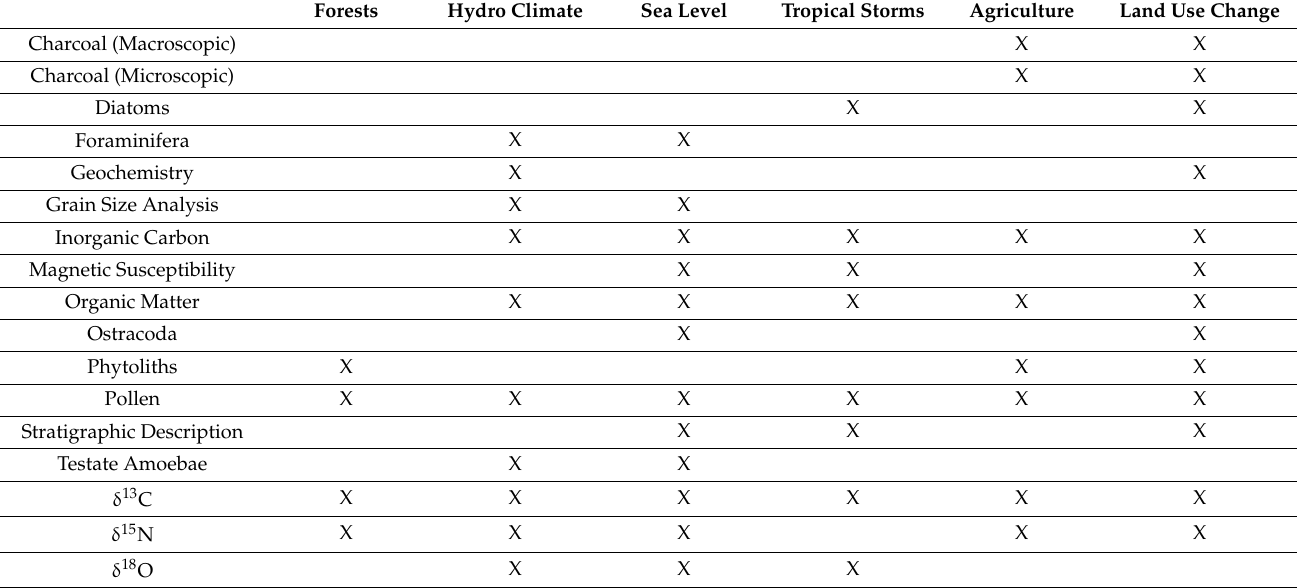
Table 6. Analyzed variable in paleoenvironmental archives and the environmental variable(s) for which it served as a proxy. Forests Hydro